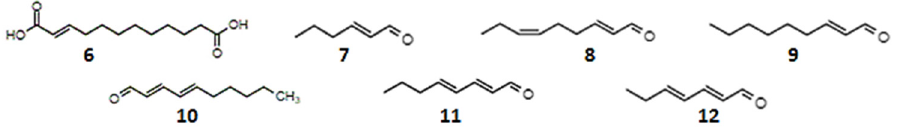
Figure 2. Chemical structures of hydroperoxide lyase branch oxylipins: traumatic acid ( 6 ); (E)-2- hexenal ( 7 ); (2E,6Z)-2,6-nonadienal ( 8 ); (E)-2-nonenal ( 9 ); (2E,4E)-2,4-decadienal ( 10 ); (2E,4E)-2,4-oc- tadienal ( 11 ); and (2E,4E)-2,4-heptadienal ( 12 ).